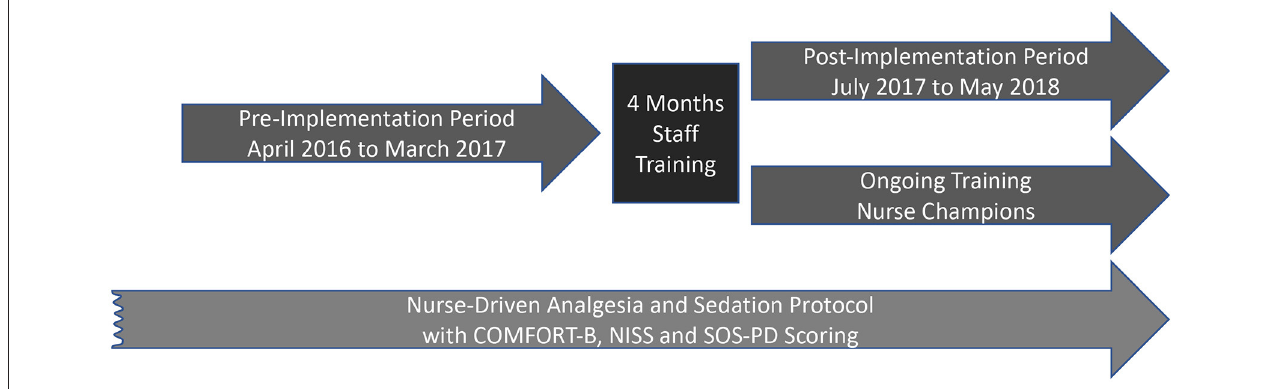
FIGURE 1 | Conceptual design of the